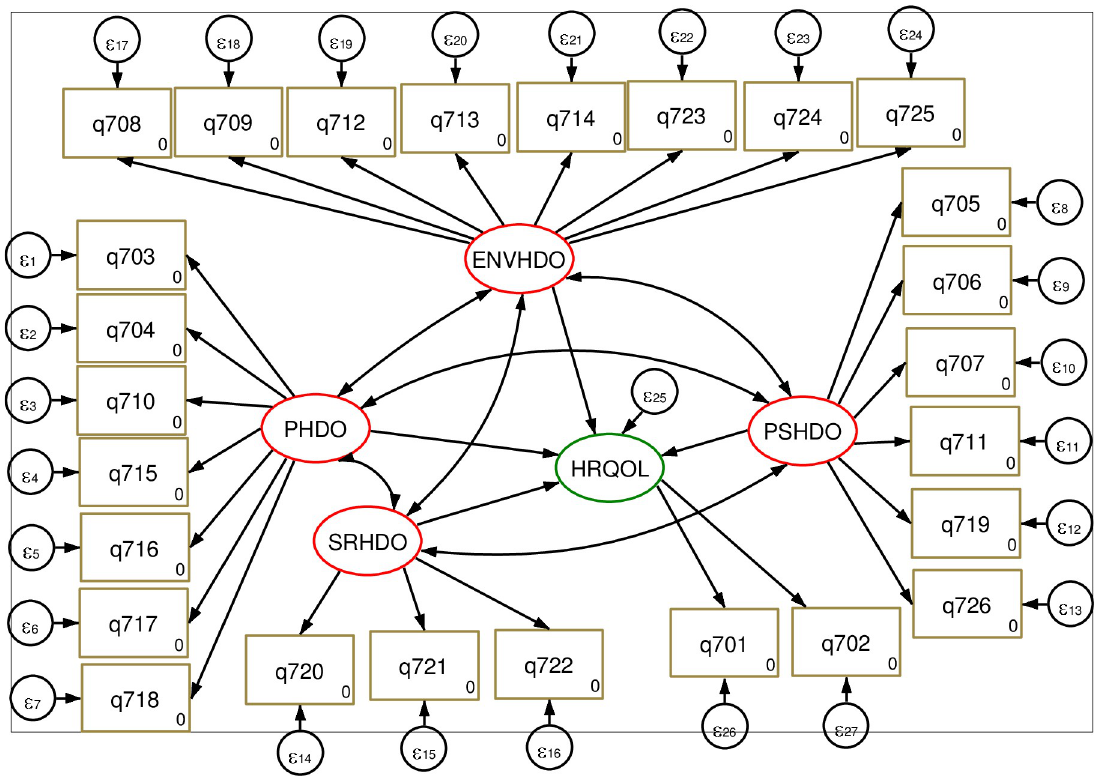
Fig 1. Hypothesized Path diagram of health-related quality of WHOHRQOL-Breff developed from the literatures [29]. Where: HRQOL: Health-related quality of life; PHD: Physical health domain; ENVHD: Environmental health domain, SRHD: Social relations domain, PSHD: Psychological health domain; q701:overall QOL, q702:overall health; q703:Pain and discomfort; q704:Medical treatment dependence; q705: Energy and fatigue; q706: Mobility; q707: Sleep and rest; q708: Daily activity; q709: Working capacity; q710: Positive feeling; q711: Spirituality/personal beliefs; q712: Memory and concentration; q713: Bodily image and appearance; q714: Self-esteem; q715: Negative feelings; q716: Personal relationships; q717: Sex; q718: Social support; q719: Physical safety and security; q720: Physical environment; q721, financial resources; q722: Information and skills; q723: Recreation and leisure; q724: Home environment; q725: Health accessibility and quality; q726: